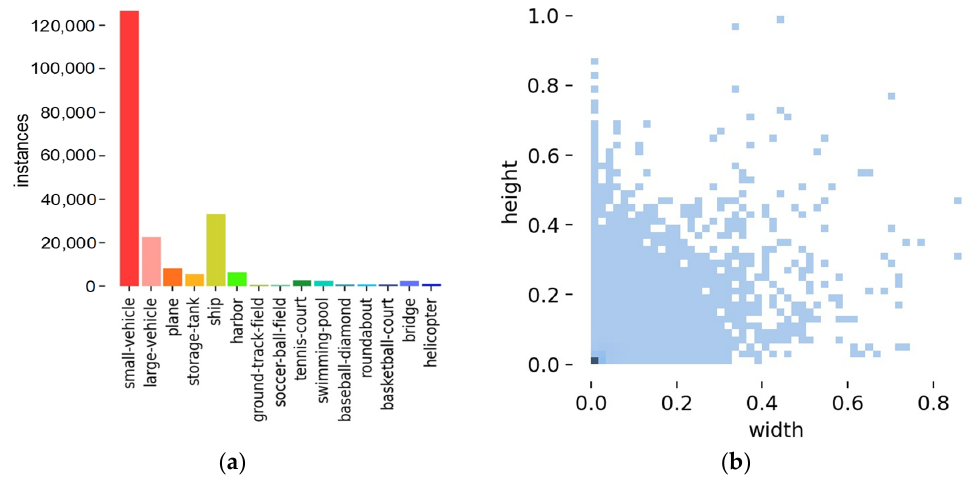
Figure 8. Distribution of classes and sizes of objects in DOTAv1.5: ( a ) Distribution histogram of the classes of the labels; ( b ) Heat map of the size of the objects.